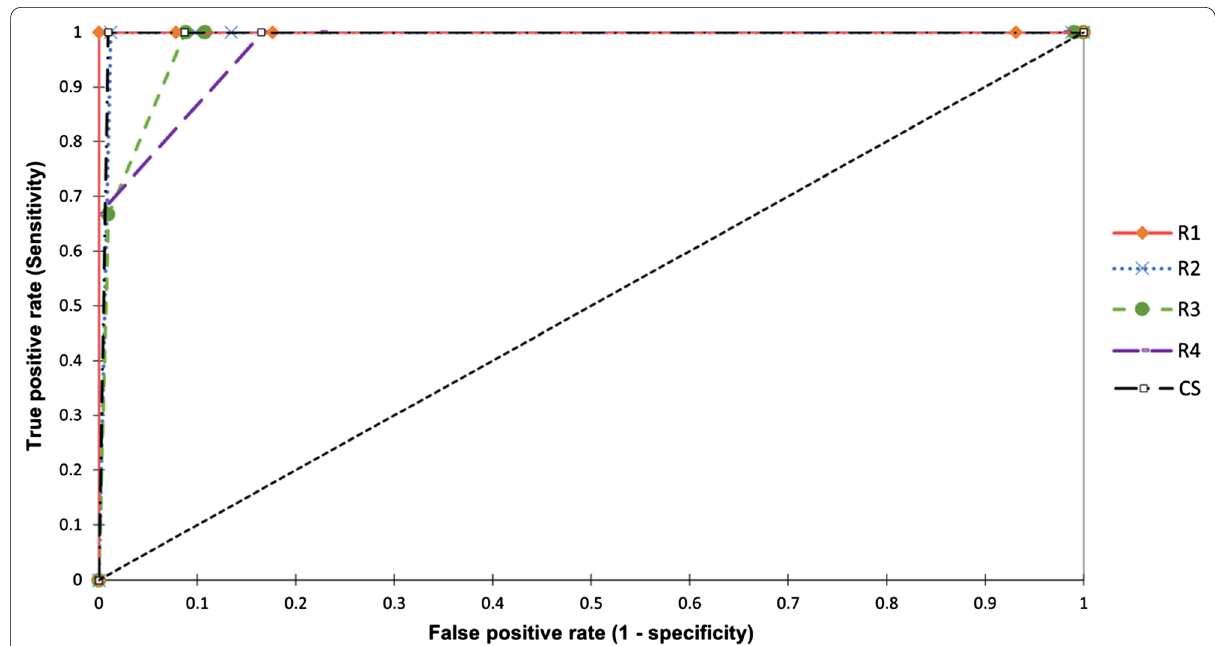
Fig. 9 Receiver operating characteristic curves (ROC) for each radiologist and the consensual decision (CS)